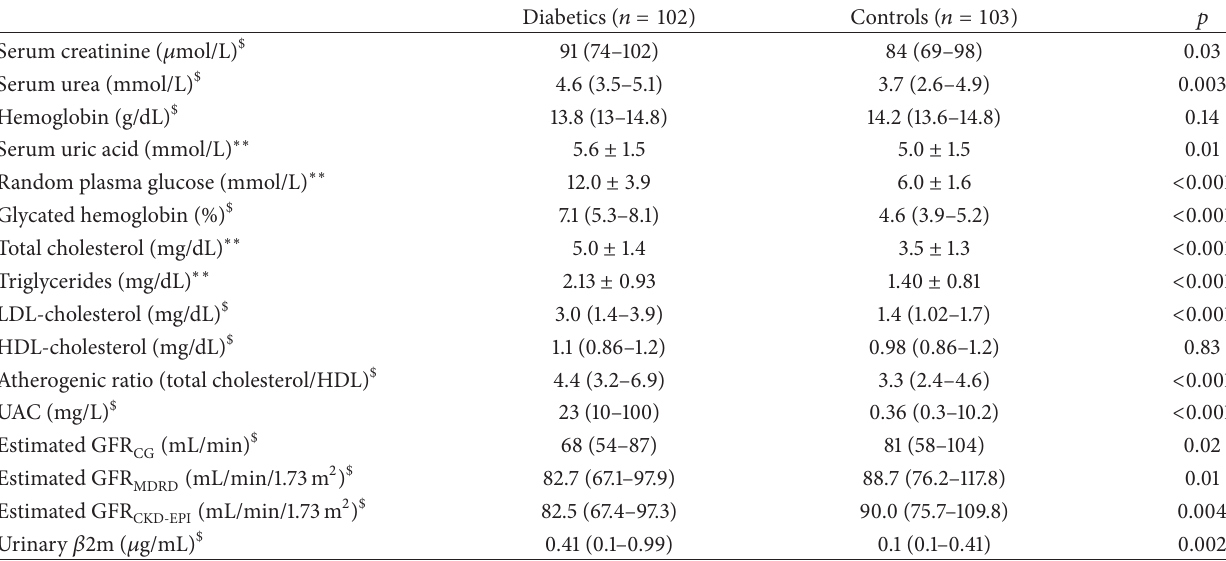
Table 2: Comparison of laboratory findings in both